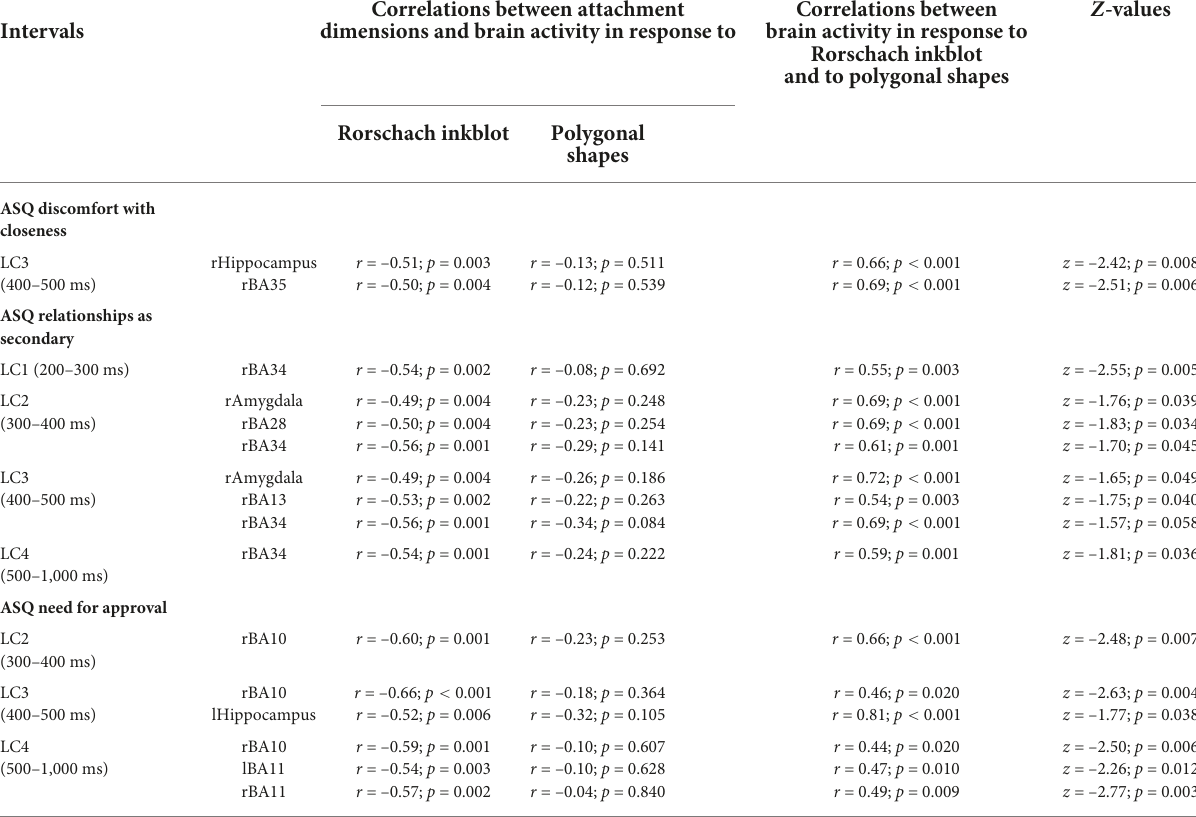
TABLE 3 Comparisons between the correlations (Pearson correlation), the ASQ dimensions (confidence, discomfort with closeness, relationships as secondary, need for approval, and preoccupation) scores and the mean activation of Brodmann areas (BAs) in response to the Rorschach inkblot vs. polygonal